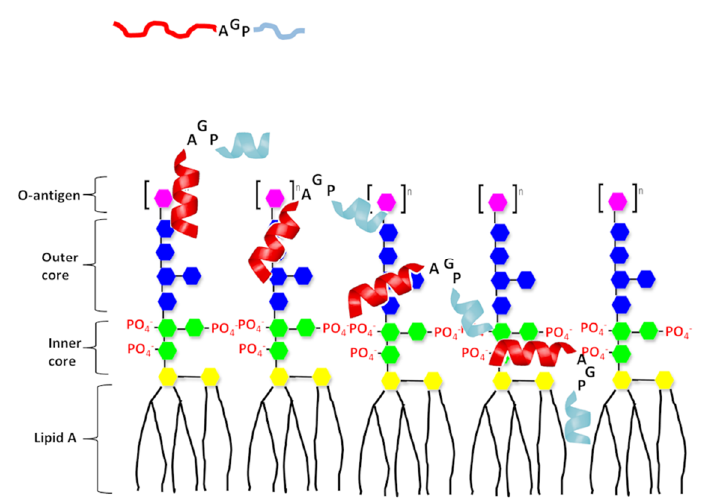
Figure 10. A proposed model of interaction of the designed peptide with LPS. The N-terminal helix of designed peptides shown in red and C-terminal hydrophobic helix shown in light blue. Structure of LPS consists three regions: polysaccharide O antigen (purple), core oligosaccharide (blue presents outer core and green presents inner core) and lipid A region. Lipid A consists of two glucosamine (yellow) units with attached acyl chains.